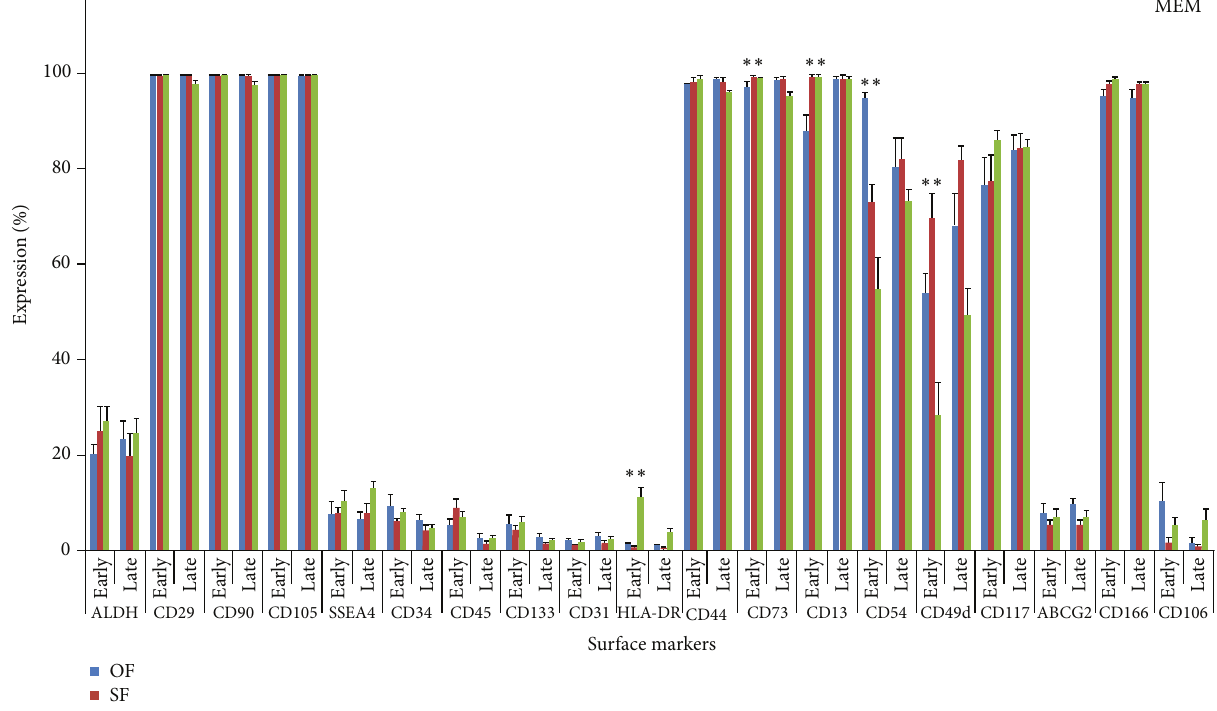
Figure 5: Marker expression profiling of MSCs cultured in Alpha-MEM. Comparative Surface antigenic profiling of MSCs derived from omentum fat, subcutaneous fat, and bone marrow at early (P3) and late (P20) passages cultured in